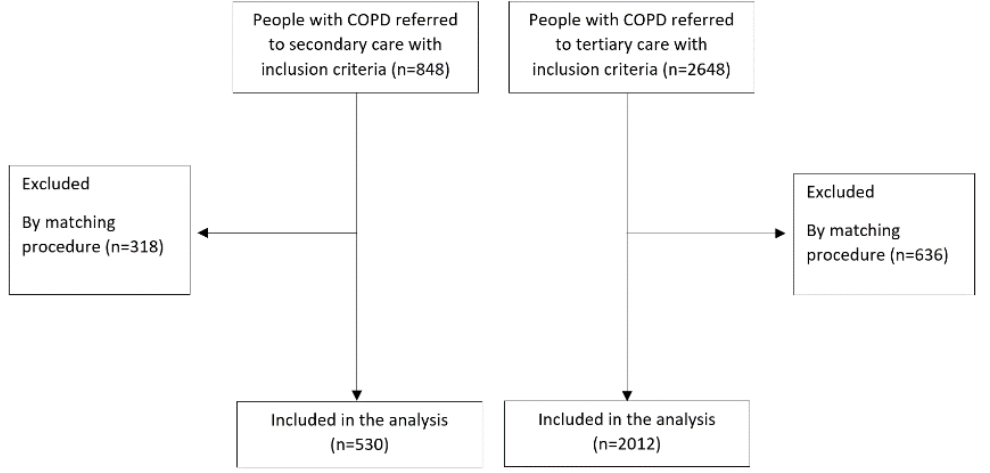
Figure 1. Flowchart of study for both samples.